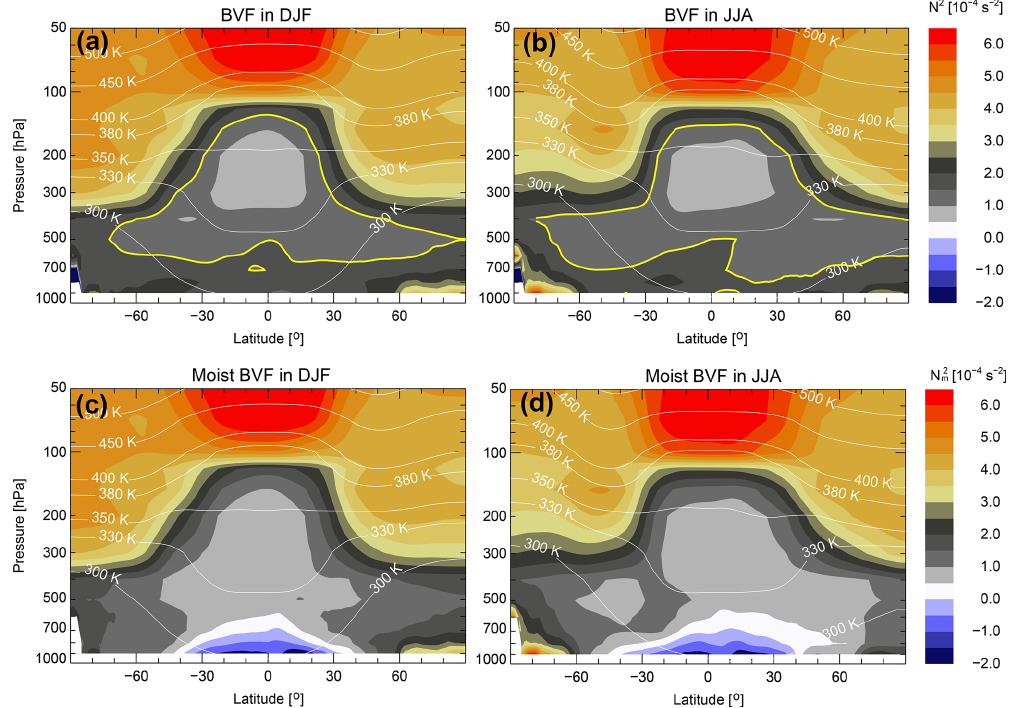
Figure 2. The zonal mean distribution of dry, N 2 (a, b) , and moist, N 2 m (c, d) , Brunt–Väisälä frequencies (BVFs) in the troposphere and the lower stratosphere for DJF (a, c) and JJA (b, d) as calculated from 2005 ERA-Interim data. The thick yellow contours in the top row highlight those parts of the atmosphere where the tropospheric mixing is included in CLaMS. The bluish colored regions in the bottom panels mark places from which additional parametrization of convection lifts the CLaMS air parcels from the PBL into the upper